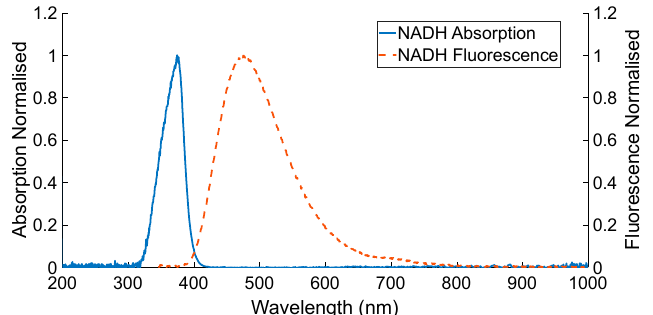
Figure 5. Photoluminescence spectrum of NADH.